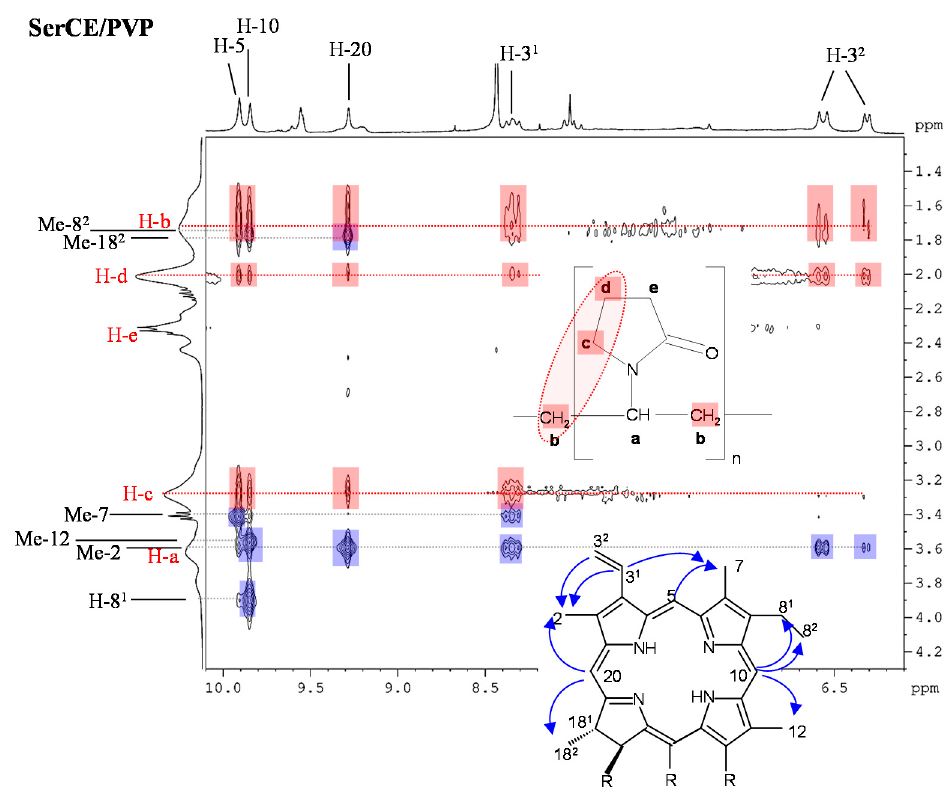
Figure 7. 2D 1 H 1 H NOESY (excerpt) of chlorin e6 serine amide (SerCe) associated with PVP at a SerCe/PVP molar ratio of 3:20 in phosphate buffered saline (PBS). ( Reprinted with permission from: M. Hädener et al. , J. Phys. Chem. B 2015, 119, 12117 − 12128. [163] Copyright © 2015, American Chemical Society. )